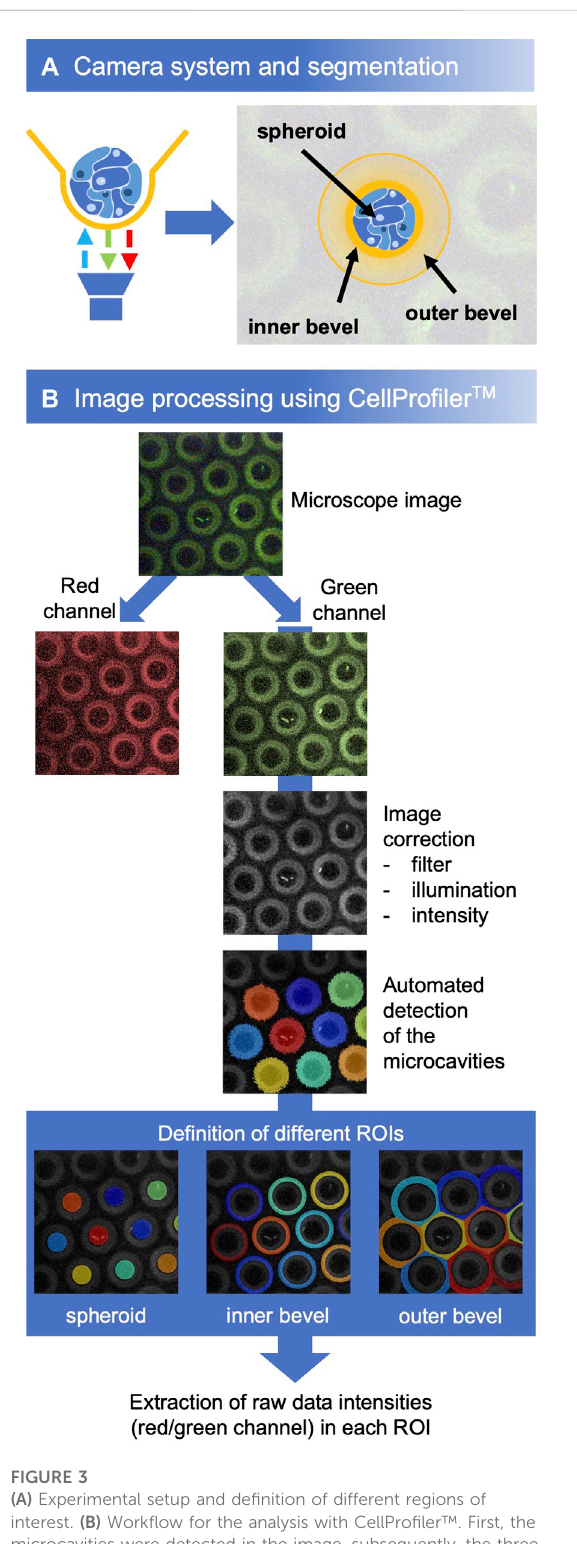
FIGURE 3 (A) Experimental setup and de fi nition of different regions of interest. (B) Work fl ow for the analysis with CellPro fi ler ™ . First, the microcavities were detected in the image, subsequently, the three regions of interest were de fi ned. For every ROI of each microcavity, the mean intensity of the red and the green signal was determined after which the oxygen concentrations were calculated with the help of the calibration